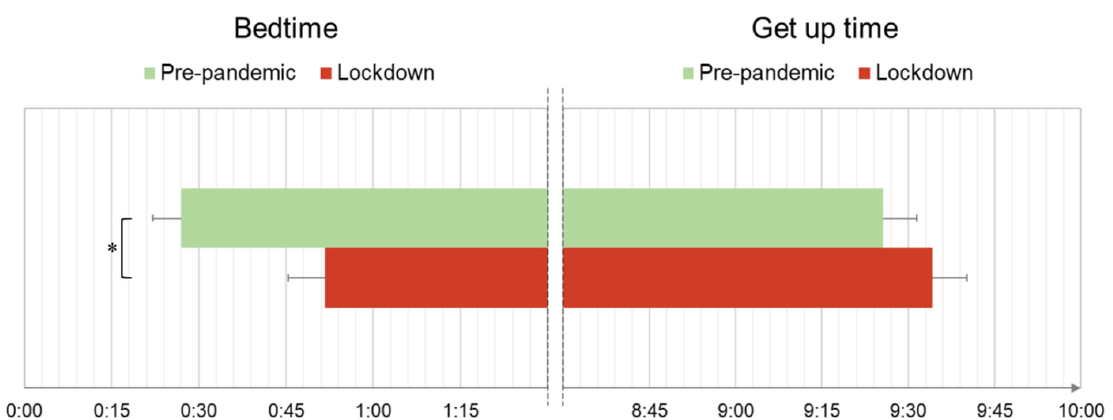
Figure 2. Sleep patterns of the two student samples (pre-pandemic, lockdown). Means and standard errors of bedtime and get up time and significance of statistical comparisons are reported (* p<0.05).